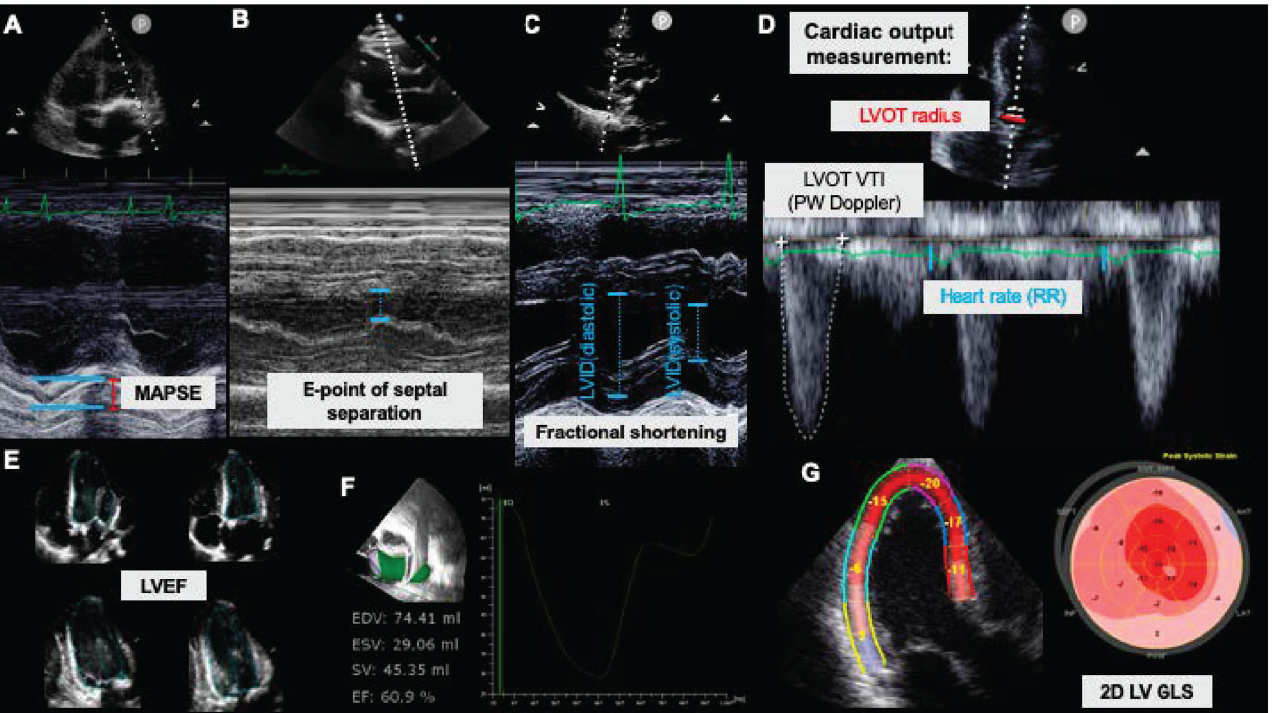
Figure 1. Echocardiographic evaluation of left ventricular systolic function . ( A ) Measurement of mitral annular plane systolic excursion (MAPSE, mm) using M ‐ mode in transthoracic apical four ‐ chamber view. ( B ) Quantification of the E ‐ point of septal separation during early diastolic inflow in the transthoracic parasternal long ‐ axis plane. ( C ) Fractional shortening is measured in the long ‐ axis view and reflects the systolic circumferential function of the left ventricle. ( D ) By measuring the velocity time integral (VTI) with the PW Doppler in the left ventricular outflow tract (LVOT) while including the LVOT radius and heart rate (RR interval) into the calculations, the cardiac output can be quantified noninvasively. ( E ) The Simpson method derives LV volumes and left ventricular ejec ‐ tion fraction (LVEF) from four ‐ and two ‐ chamber views. This requires tracing of the endocardial border in the end ‐ diastolic and end ‐ systolic frames. ( F ) Three ‐ dimensional echocardiographic ac ‐ quisition of the entire left ventricle provides accurate volumetry and LVEF measurement. The tech ‐ nique is usually combined with semi ‐ automatic speckle ‐ tracking to allow for quick and robust anal ‐ yses. ( G ) Speckle ‐ tracking is further applied to 2D long ‐ axis views of the left ventricle to measure longitudinal strain. The 2D LV global longitudinal strain of the LV (GLS) is a parameter with a better prognostic power compared to LVEF. EDV: end ‐ diastolic volume; ESV: end ‐ systolic volume; LVID: left ventricular inner diameter; SV: stroke volume.